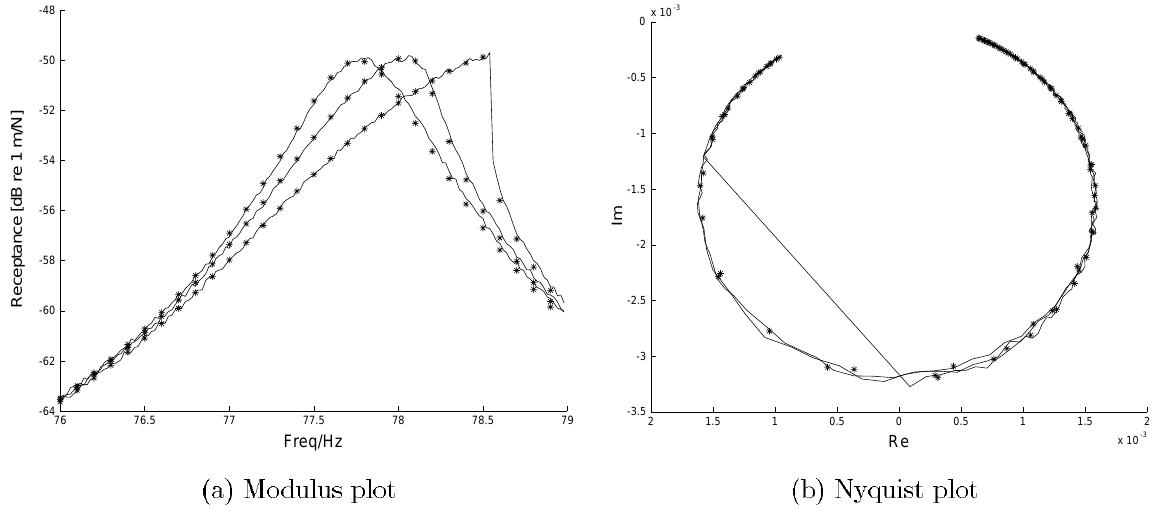
Fig. 9. Regeneration from noise-polluted data: HBM simulation, ∗ ∗ ∗∗ Regenerated